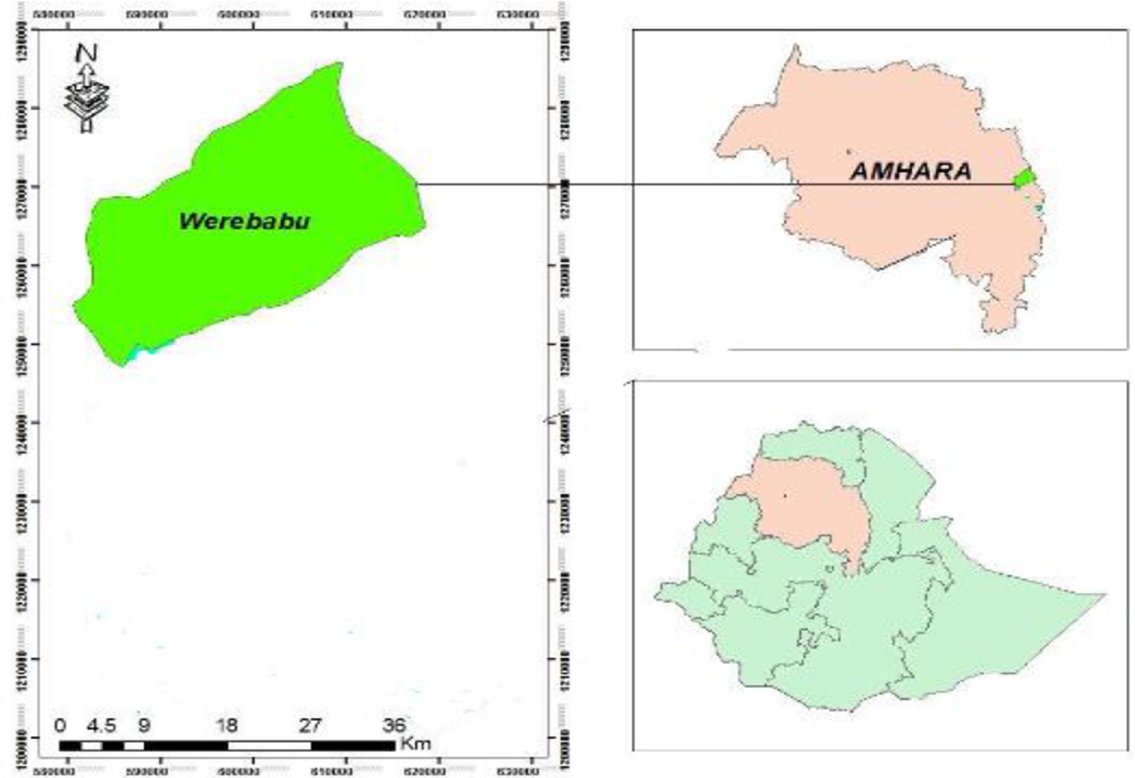
Fig 1. Map of WerebBabu District, South Wollo Zone, Northeast Ethiopia, July 2020 taken from the Woreda administrative office.